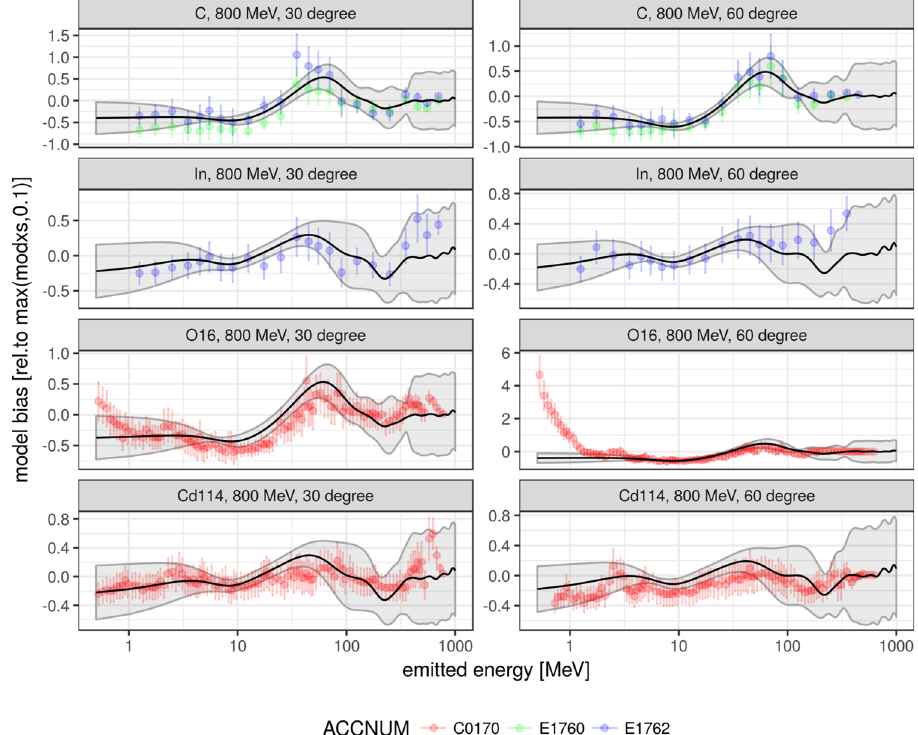
Fig. 2. Model bias of INCL in terms of equation (30) in the ( p , X ) n double differential spectra for 800 MeV incident protons and different isotopes as predicted by GP regression. A missing mass number behind the isotope symbol indicates natural composition. The uncertainty band of the prediction and the error bars of the experimental data denote the 2 s con fi dence interval. Carbon and indium were taken into account in the GP regression but not cadmium and oxygen. The experimental data are colored according to the associated access number (ACCNUM) in the EXFOR database. This shows that all displayed data come from just three experiments [20 –